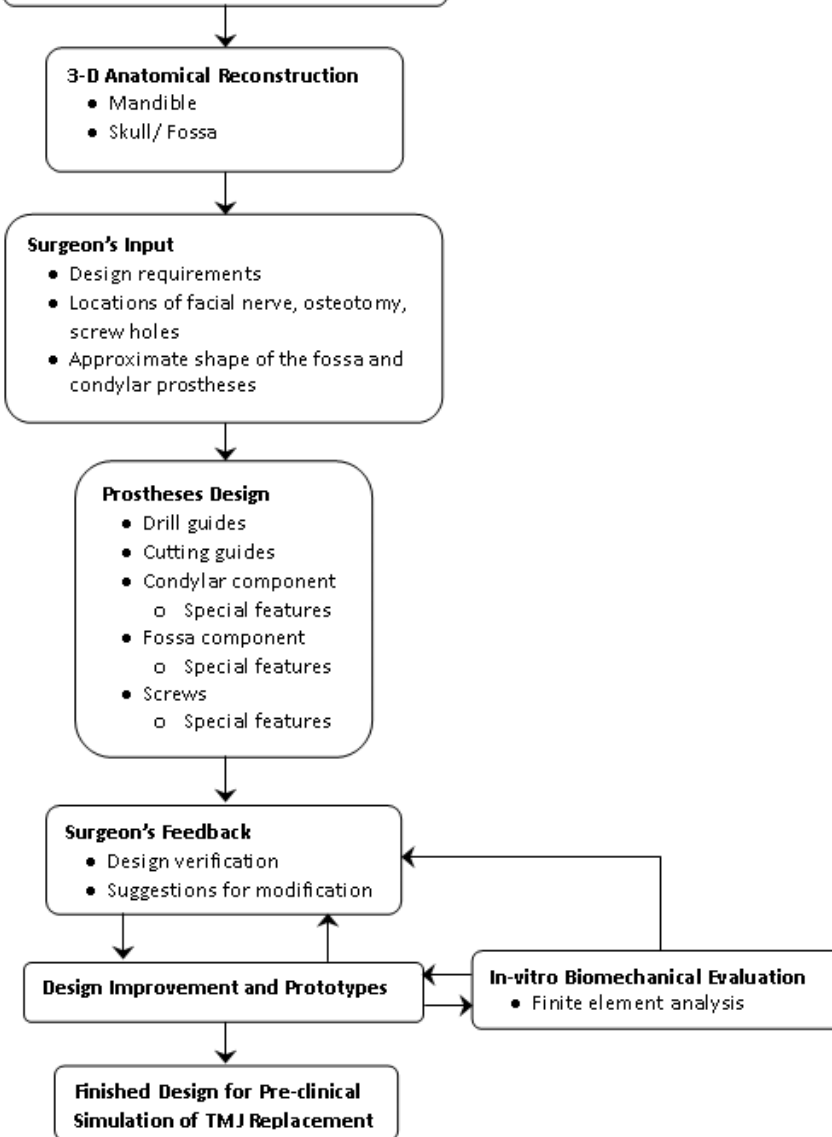
Figure 1. Methodology followed for design and preliminary analysis of the patient-specific total temporomandibular joint (TMJ) prostheses.